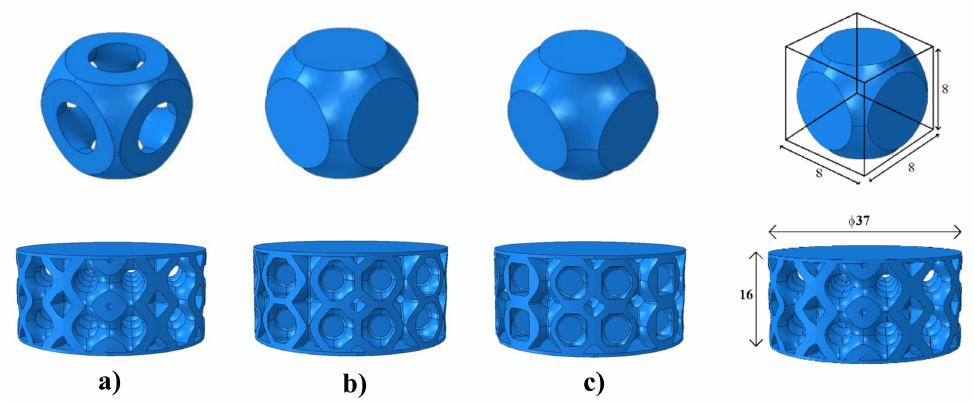
Figure 1. Unit cells and, respectively, lattice structures with their appropriate geometries and sizes [mm]: ( a ) open cell; ( b ) closed thin-walled cell; ( c ) closed thick-walled cell. Hence, this paper aimed at evaluating the stiffness of produced lattice structures